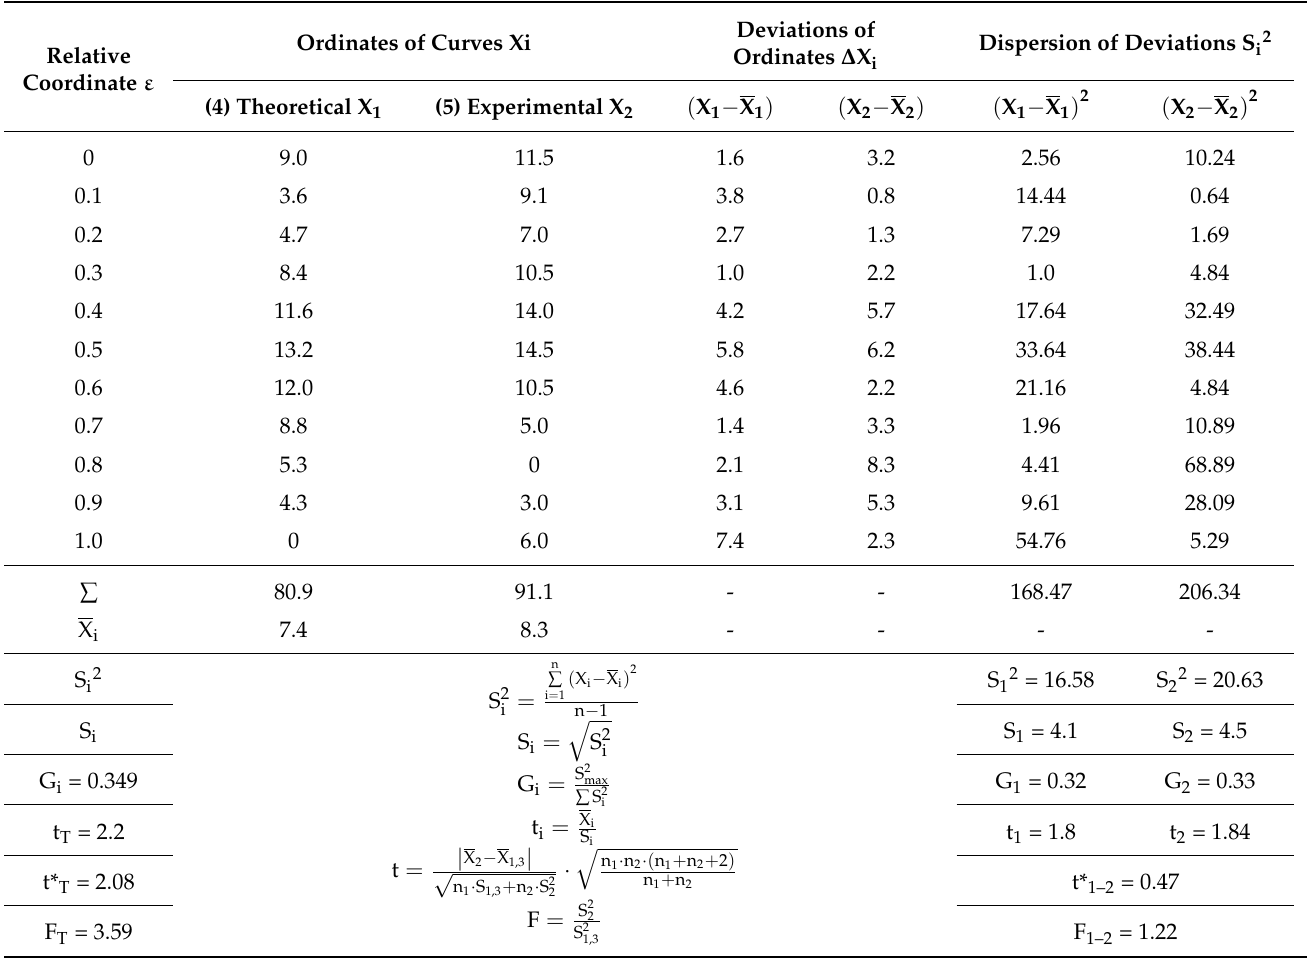
Table 4. Dispersive analysis of the results of experimental tests of samples with diameter d = 8 mm with non-uniform compensation of the compliance of the technological